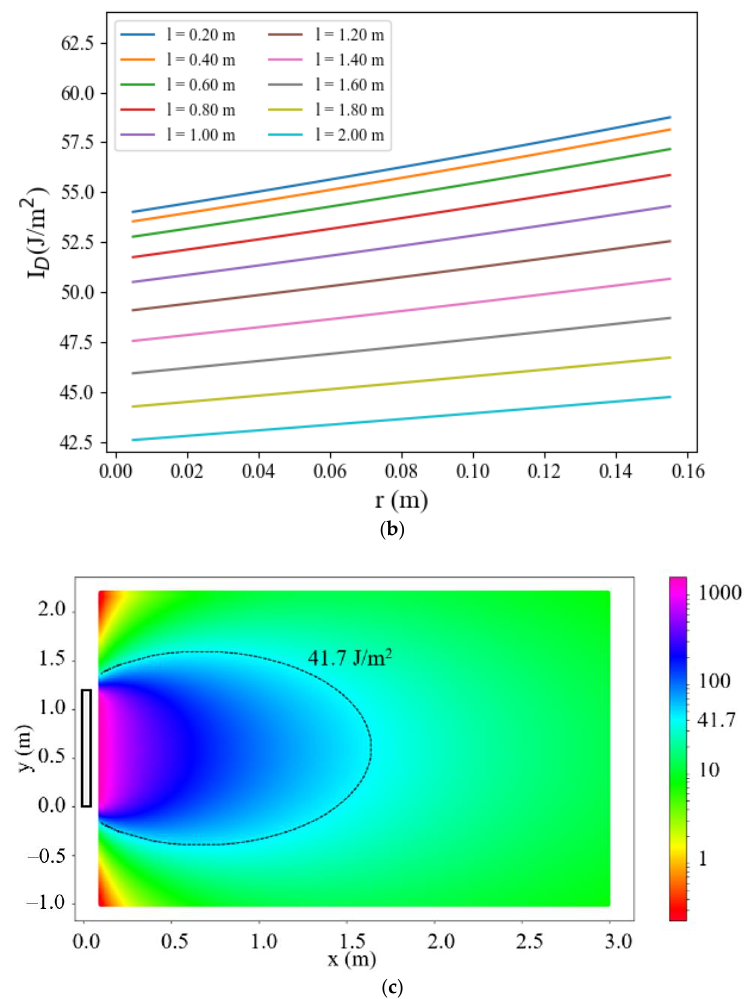
Figure 1. ( a ) Schematic diagram of the differential element and the cylindrical UVC lamp. The UVC intensity at ( b ) 1.5 m from the cylinder axis with various radii and lengths of the lamp, and ( c ) arbitrary points of the lamp with a 1.2 m length and 0.011 m radius. The exposure time is 30 s, and the total UVC power is 40 W. The color bar shows the value of light intensity in the unit J/m 2 , and the dashed line represents 41.7 J/m 2 . Sensors 2021 , 21 , x FOR PEER REVIEW By using (1) and (2), the intensity of UVC light from a cylindrical lamp with a differ- ent r and l and at arbitrary points with a different x and y can be drawn as Figures 1b and c, respectively. In Figure 1b, the UVC light focuses on the main beam, which is the per- pendicular direction from the center of the UVC lamp, with a smaller length and larger radius of the lamp. In Figure 1c, the lamp is installed at x = 0, y = 0 − 1.2 m, the radius r is 0.011 m, the exposure time t is 30 s, and the UVC power from the lamp E is 40 W. Results show that the 41.7 J/m 2 UVC intensity (D90 value of COVID-19) can be achieved within the dashed-line region (Figure 1c), which covers x = 0 − 1.6 m for the main beam direction. Hence, the sterilization procedure can be completed in 30 s within a 1.6 m radius using the disinfection vehicle with a UVC lamp , as shown in Figure 2.